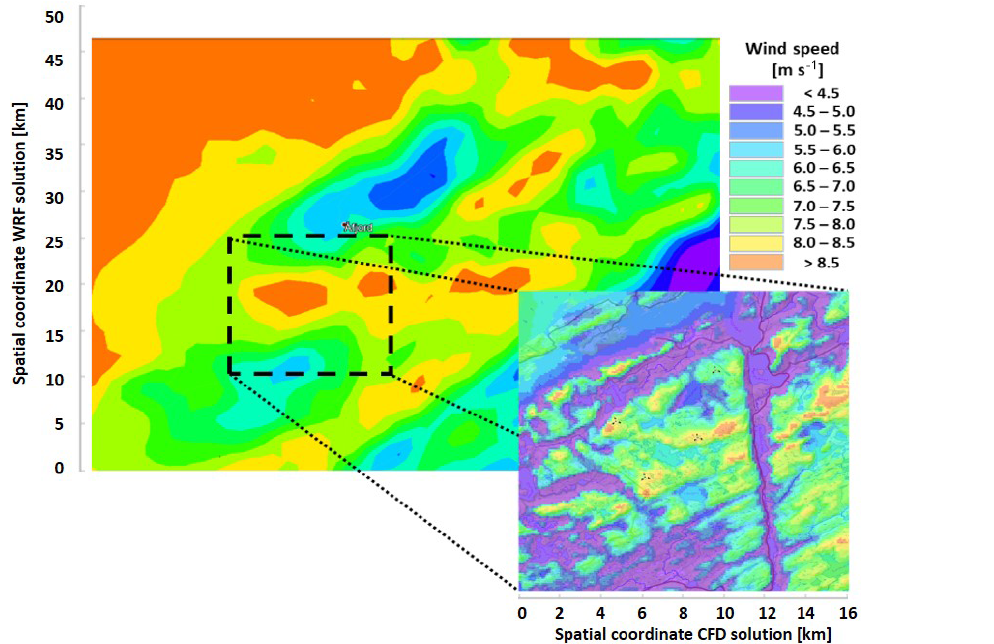
Figure 1. Illustration of the ME-WAM method. The background contour is extracted mean wind speed from the WRF model. The black dashed box indicates the location where a microscale CFD analysis is conducted to add resolution in the results. By comparing the two velocity fields, which have the same colour setting, it is clear that the microscale effects are important to assess the local wind speed and to be able to design a wind farm in the investigated area.